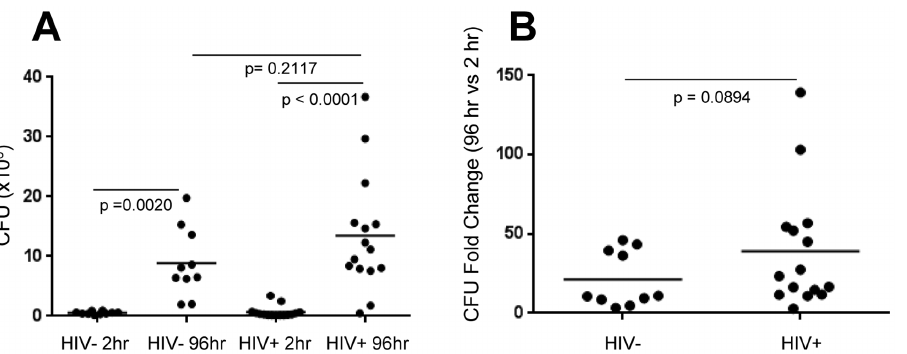
Figure 1. M.tb replication in whole blood from HIV- and HIV + subjects. (A) Total (intra- and extra-cellular) M. tb CFU counts after 2 and 96 hr in blood from 10 HIV- donors or in blood from 15 HIV + patients. (Wilcoxon Mann-Whitney two-tailed analysis; P values # 0.05 statistically significant) (B) M. tb CFU fold change between 2 hr and 96 hr in blood from HIV- donors and HIV + patients (same as in panel A). (Mann-Whitney two-tailed analysis; P value , 0.05 statistically significant). HIV- or HIV + blood environments or both, and by functional category